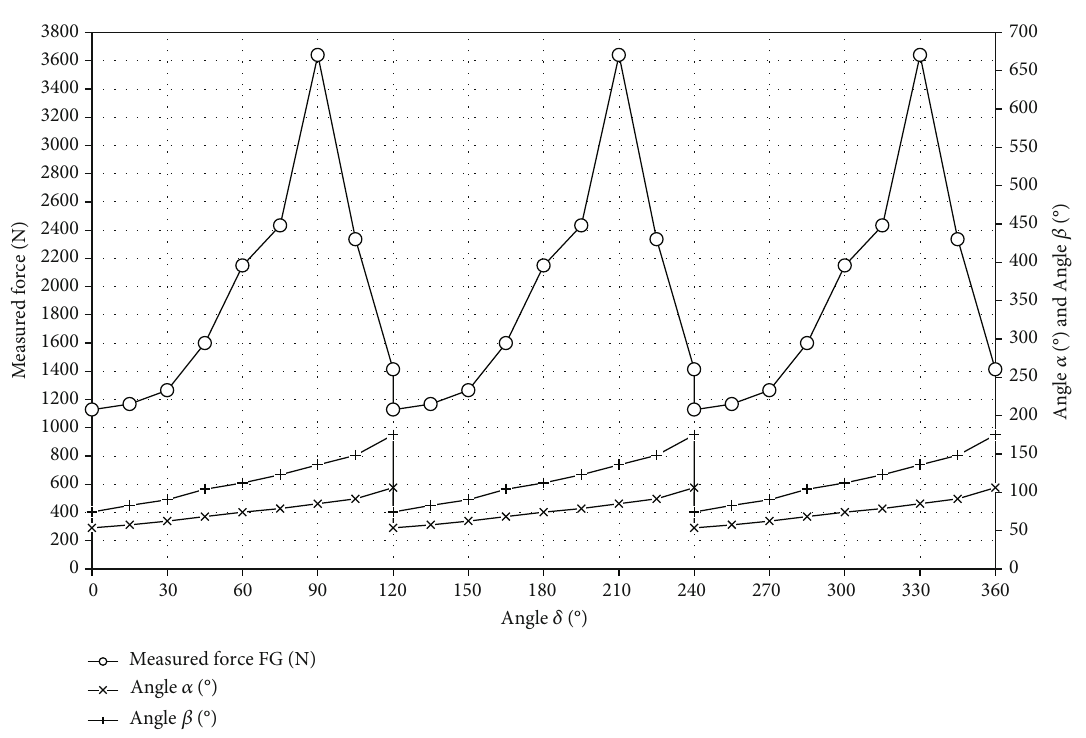
Figure 14: The measured force as a function of the angle δ (the gantry